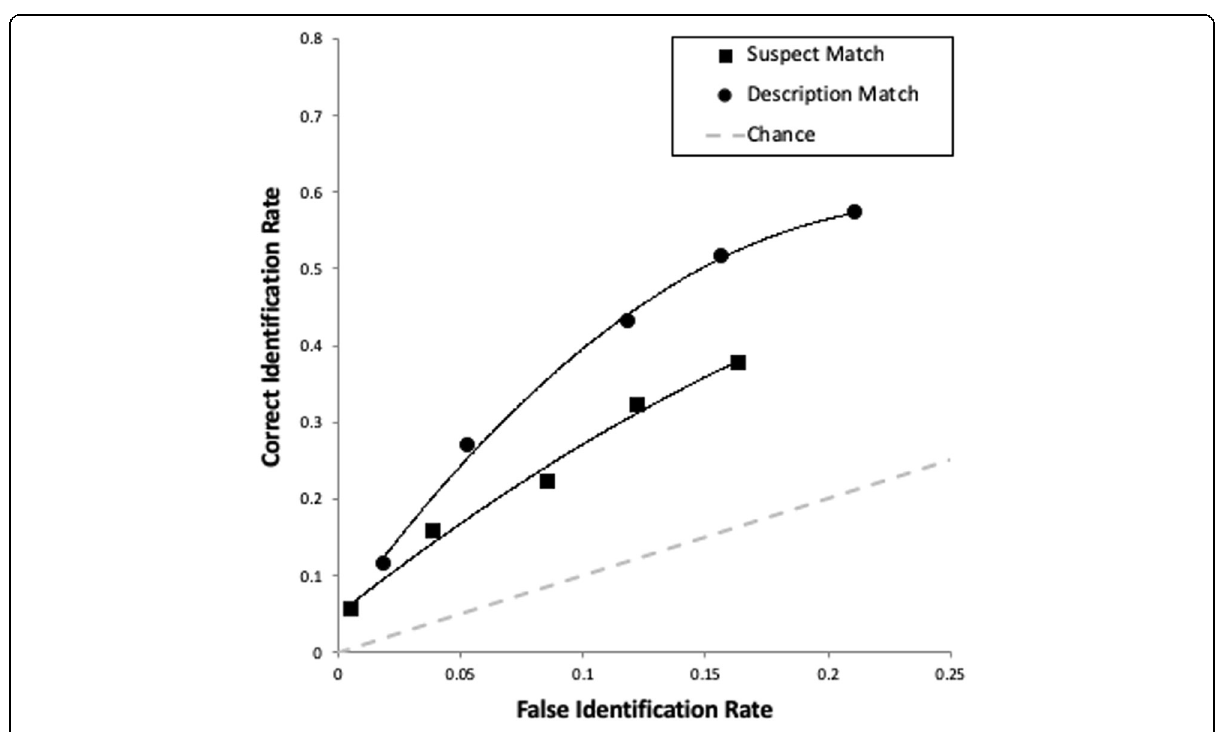
Fig. 3 ROC data (with trendlines) from Experiment 2 collapsed over the different description-matched and suspect-matched lineups. The false ID rate on the x axis is the proportion of innocent suspect identifications from the total number of target-absent lineups in a given